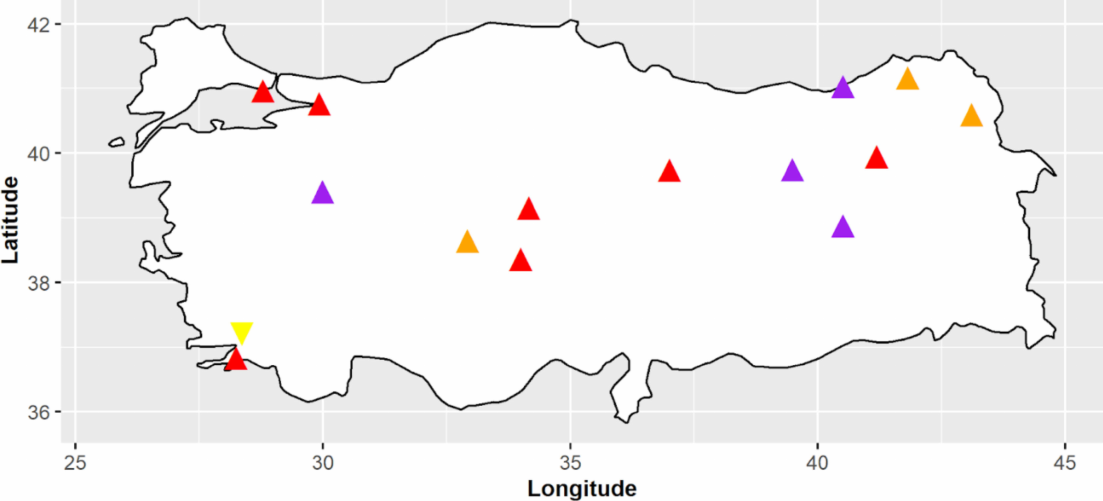
Figure 6. Mann-Kendall trend results of TCI values for winter (Red upper triangle denotes increasing trend at the 10%significance level, purple upper triangle denotes increasing trend at the 5% sig- nificance level, brown upper triangle denotes increasing trend at the 1% significance level, yellow lower triangle denotes decreasing trend at the 10% significance level, green lower triangle denotes decreasing trend at the 5% significance level and blue lower triangle denotes decreasing trend at the 1% significance